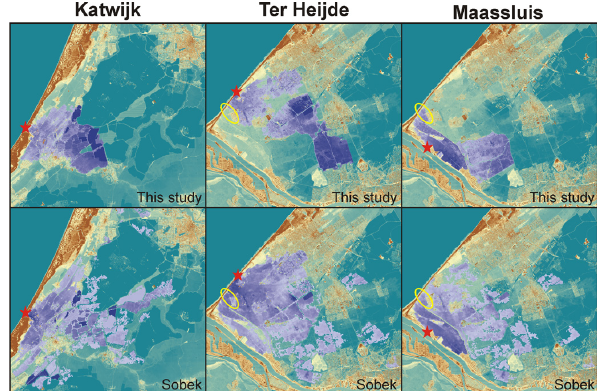
Fig. 4. Comparison of inundated areas using the approach devel- oped in this study with simulations using a 2-dimensional hydrody- namic model (Sobek). Note how the absence of a line-element in the west (yellow ellipse) in the parameterization of Sobek result in different inundation extents for the Maassluis and Ter Heijde